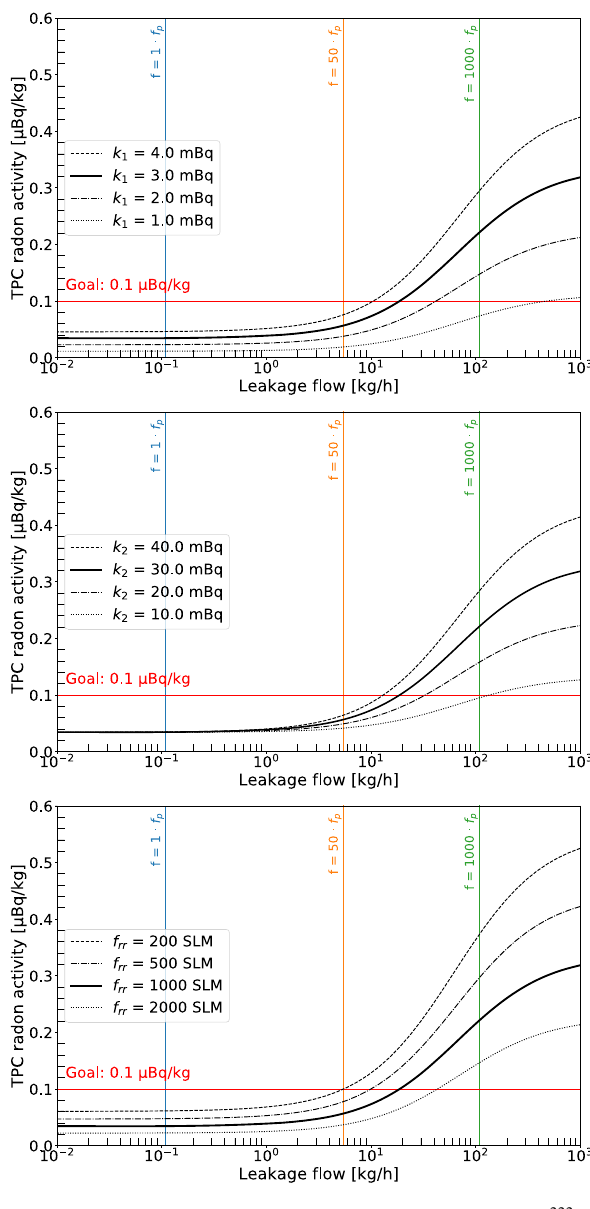
Fig. 6 Impact of detector parameters on the expected specific 222 Rn activity in DARWIN, for different levels of hermeticity defined by the leakage flow. The thick black line is identical in all panels and corre- sponds to 222 Rn emanation rates k 1 = 3 mBq and k 2 = 30 mBq in the inner and outer volumes, respectively, and a feeding flow f rr = 1000SLM to a radon removal system. One of these parameters is var- ied in the individual panels (top: k 1 , center: k 2 , bottom: f rr ) while the other two are kept constant. Three different ways of scaling up the her- meticity result of the prototype detector (see text) are indicated by the vertical lines. All scenarios show the great potential of a hermetic TPC toachieve the 222 Rn concentrationgoal of 0.1 µ Bq/kg in DARWIN (red line), especially in combination with other radon reduction